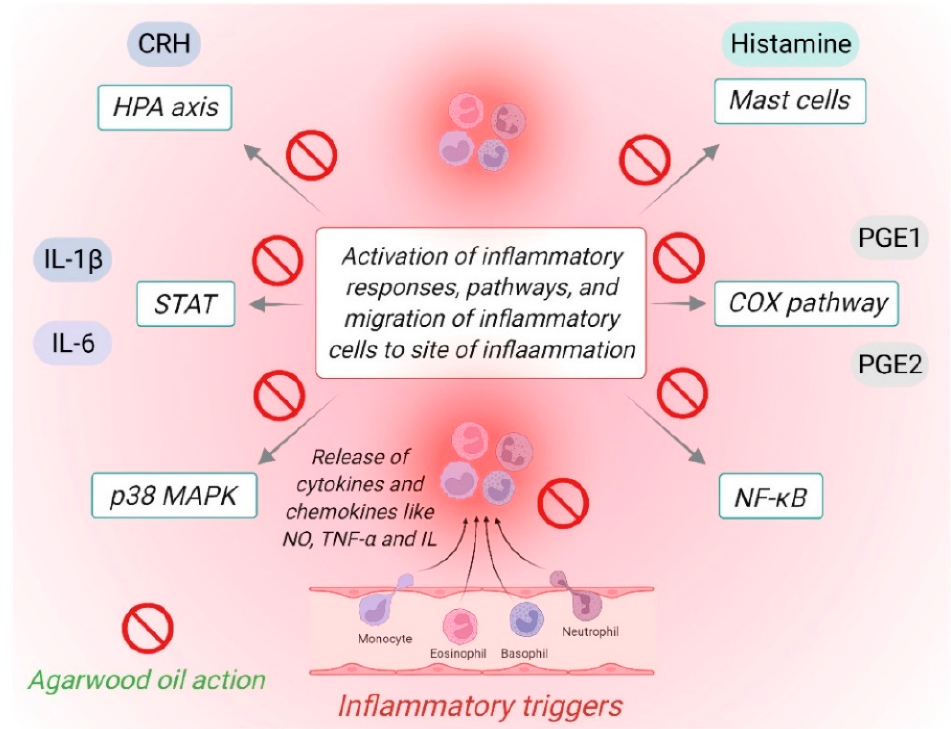
Figure 2. Possible mechanisms by which agarwood oil could inhibit chronic inflammatory pro- cesses.